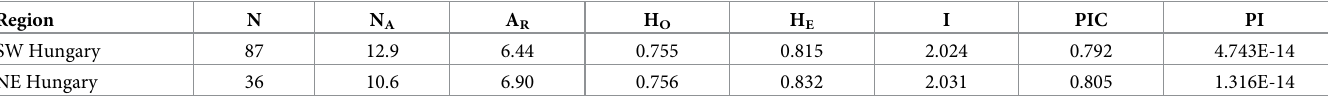
Table 5. Genetic diversity measures averaged over ten DeerPlex STRs for the red deer subpopulations analyzed. Region N N A A R H O H